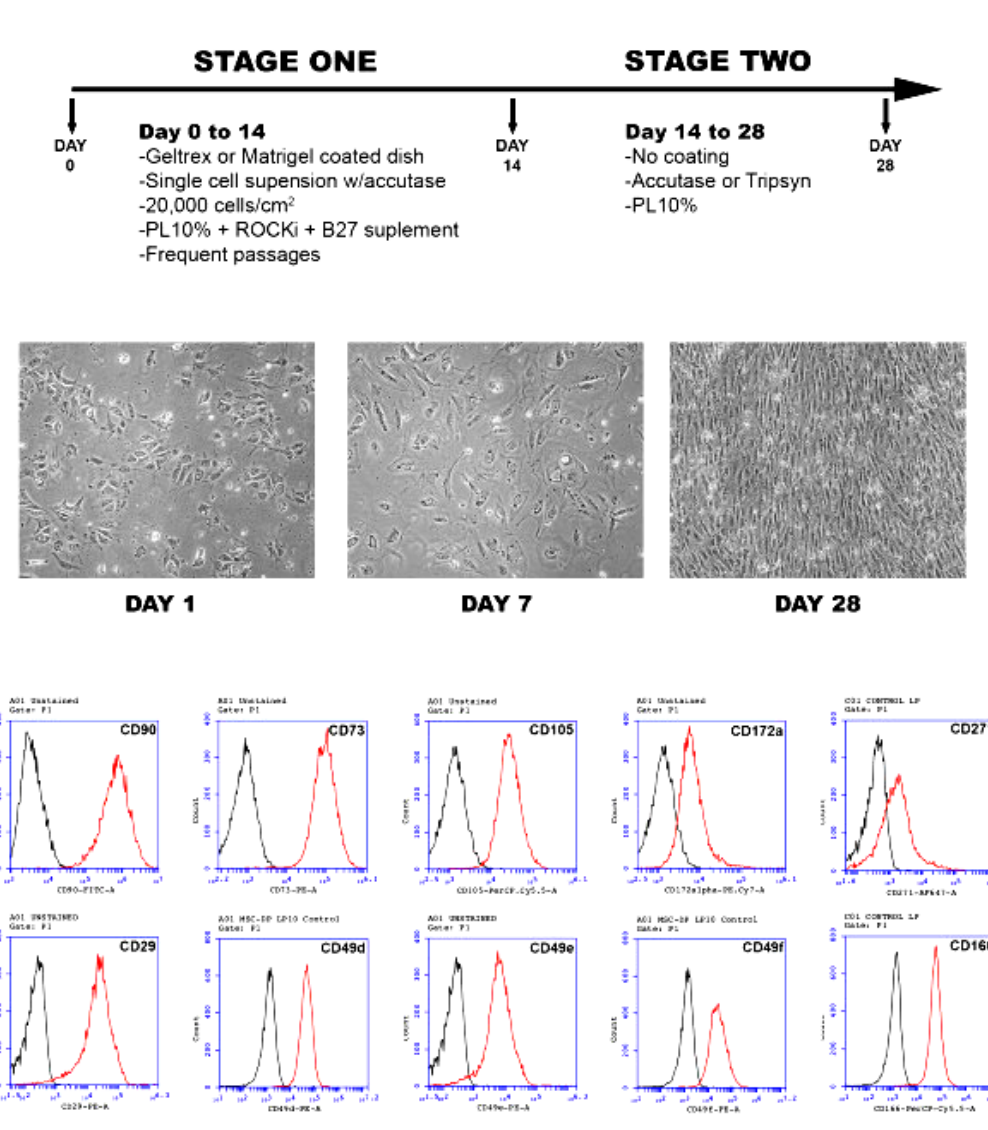
Figure 5. Representative figure showing the protocol for the production of induced pluripotent stem cells (iPSC)-MSCs using 10% using platelet lysate (PL) and the characterization of differentiated cells that shown in the microscopic changes in the cell morphology and the positive expression of MSC-associated markers with fluorescence-activated cell sorting (FACS) analysis. This figure is reproduced from article published by Luzzani et al. [129], which is an open access article distributed under the terms of